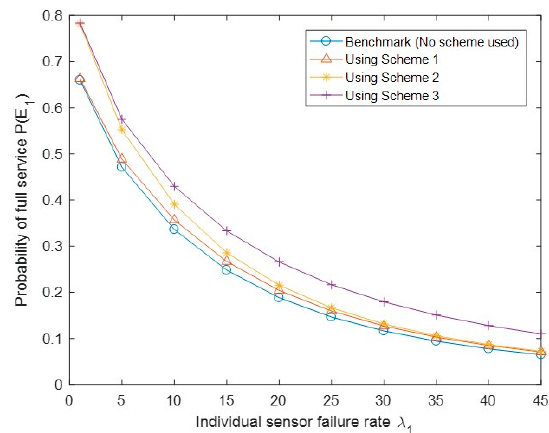
Figure 11. Performance comparison of the probability of full service P ( E 1 ) under the benchmark and three API schemes.